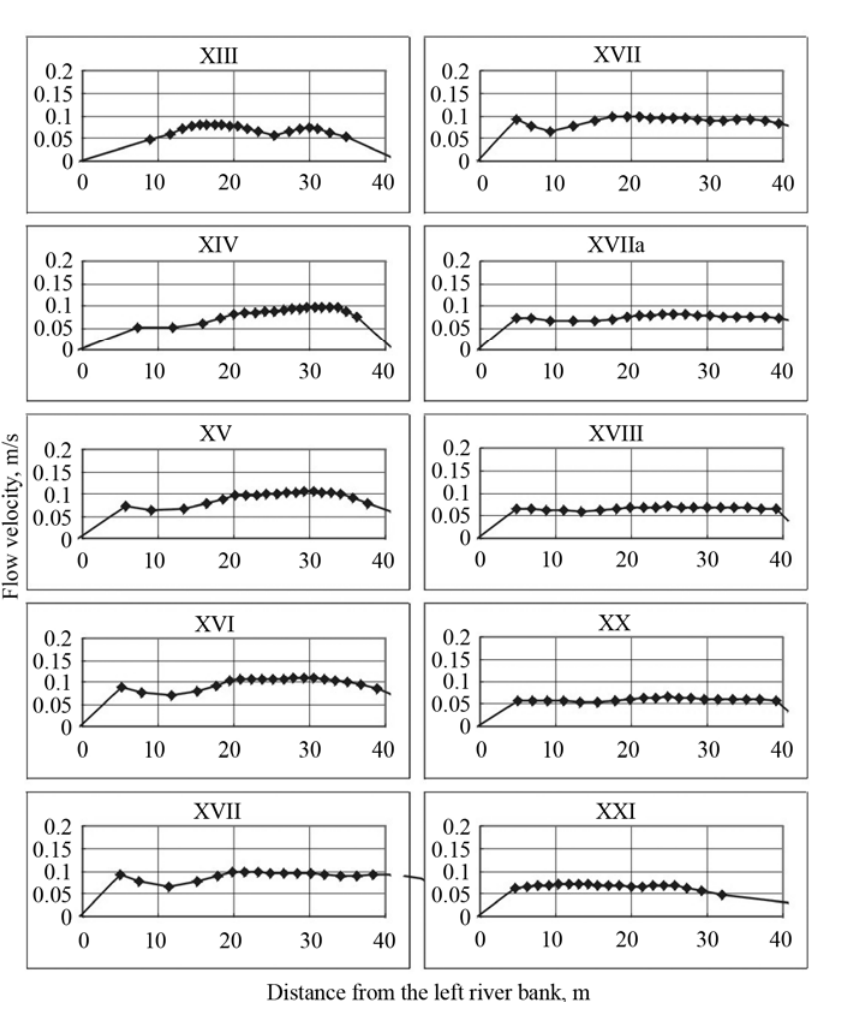
Fig. 7. Flow velocities at cross-sections XIII–XXI (in dam pond), when discharge is – 3 m 3 /s Several variations of channel depth and width were